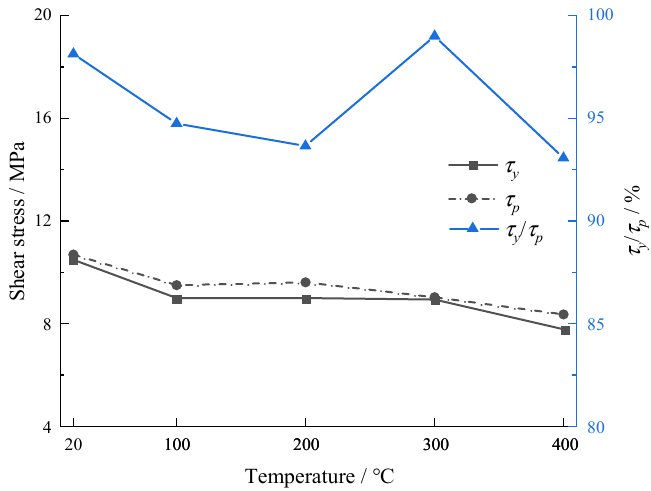
Figure 13. Yield stresses after thermal treatment (Note: τ p data are from Zhao et al. [77]).